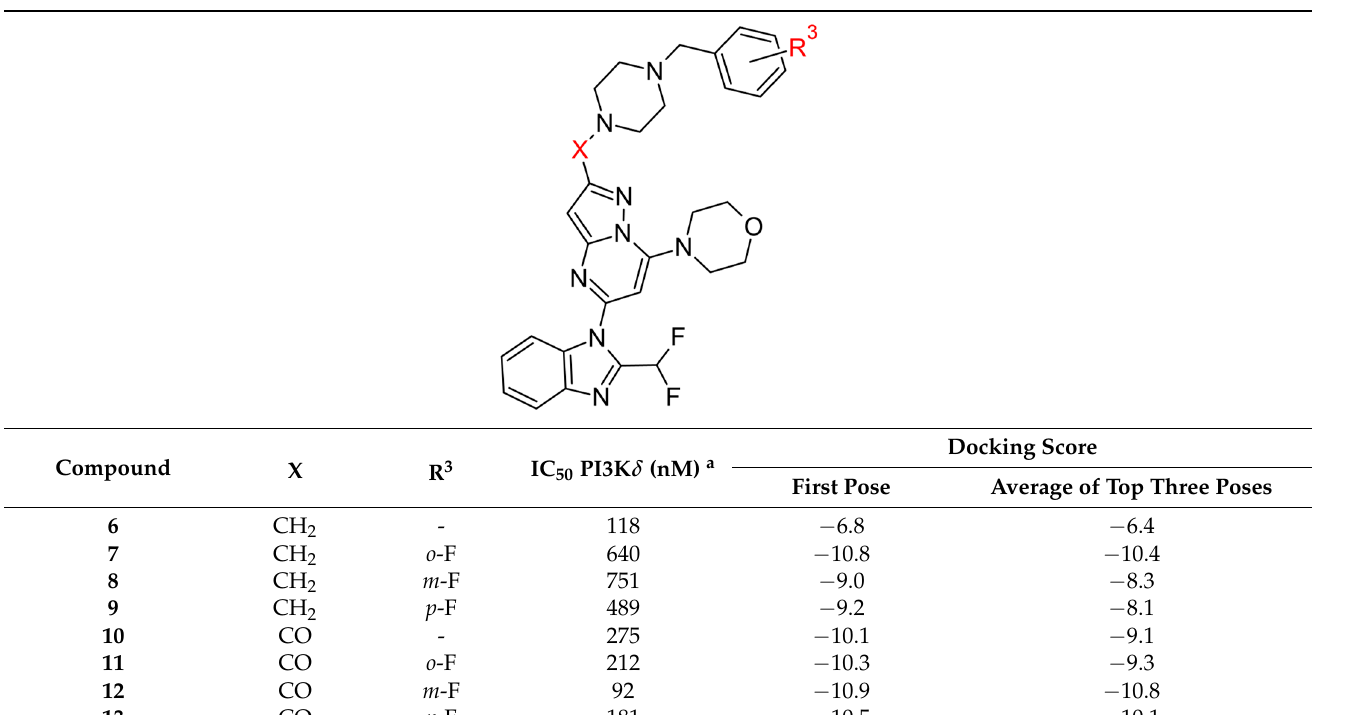
Figure 3. Illustration of the binding modes of compounds 6 (green) and 10 (orange) in the catalytic center of PI3K δ obtained by molecular docking. Table 2. Influence of the fluorine atom(s) on PI3K δ inhibition and the respective docking scores for each compound.